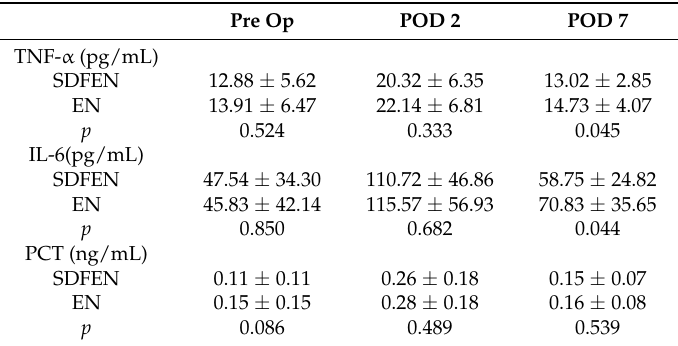
Table 5. Comparison of the two groups’ immune